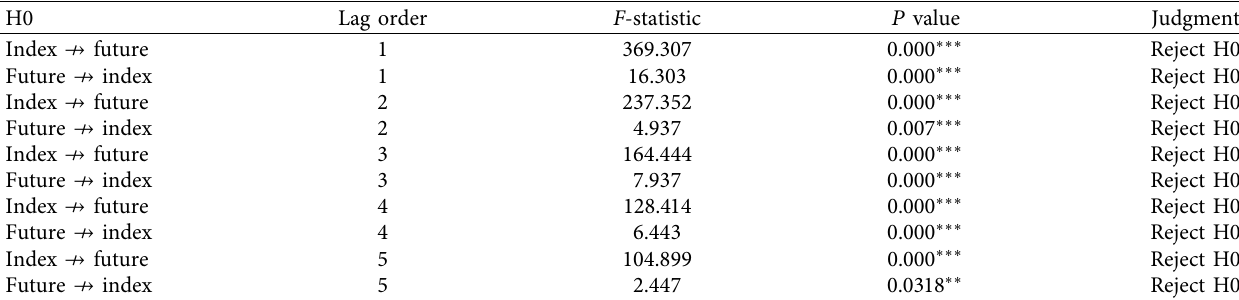
Figure 3: Price dynamics of the spot index and stock index futures. Table 9: Granger causality tests for the two market returns.